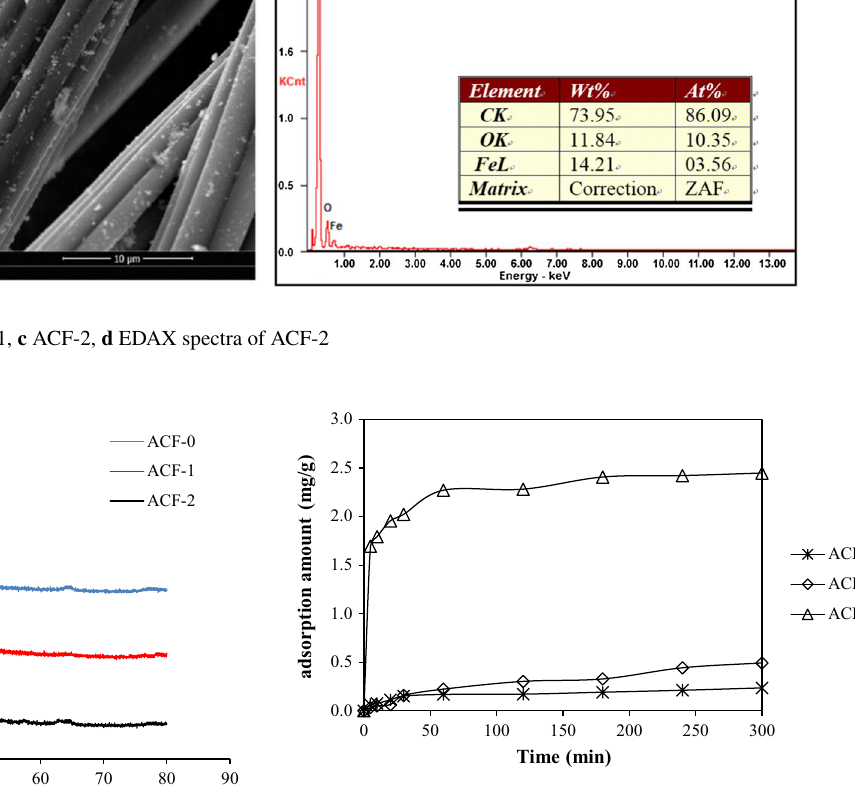
Fig. 4 Adsorption kinetics of As(III) by ACF. Concentration of As(III) was 2 mg/L; dosages of absorbents were 500 mg/L, and the initial pH was